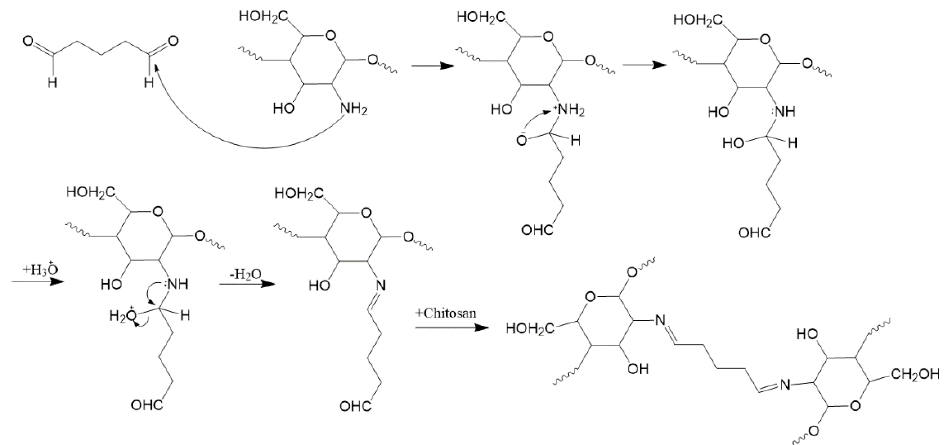
Figure 5. The formation of glutaraldehyde-based cross-links between chitosan chains via the for- mation of Schiff base imine functionalities. The chitosan polymer chains are chemically bonded by Schiff base imine bridges via crosslinking, creating a sterically more rigid structure [30].